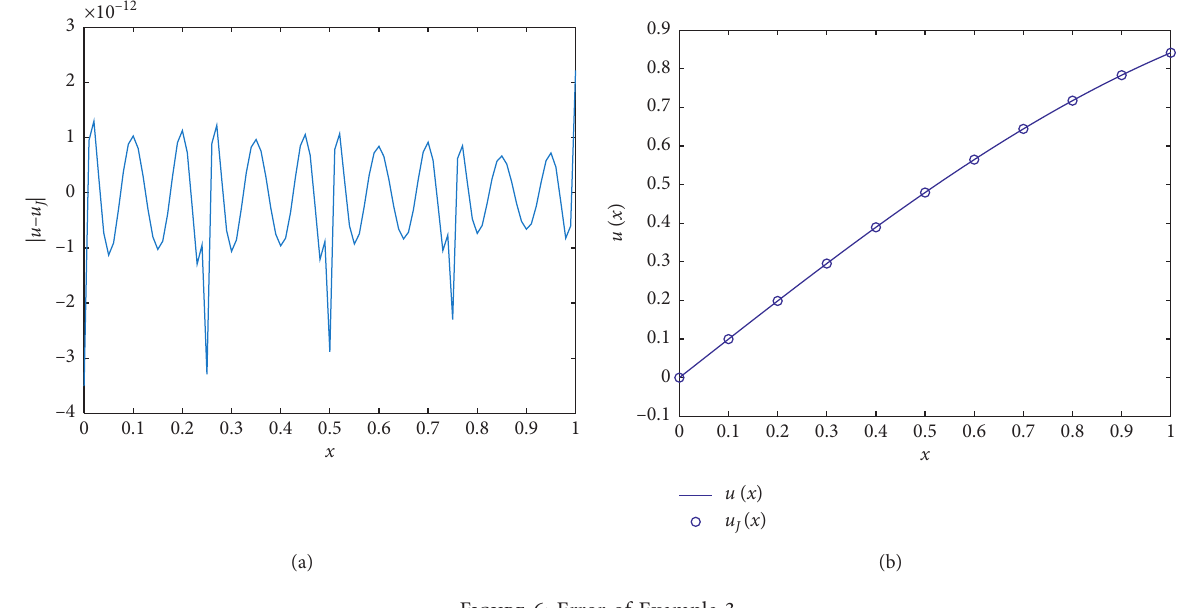
Figure 6: Error of Example 3. Table 3: Effects of parameters r , J , and ε on sparsity and L